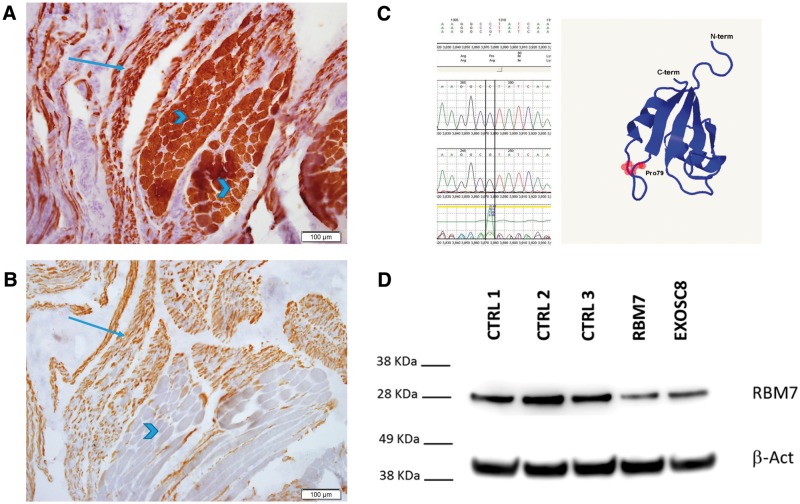
Frozen sections stained with immunohistochemical stains for slow- (A) and fast-myosin (B) display striated muscle tissue with large group atrophy, including atrophic myofibers of both types, alongside groups of hypertrophic myofibers, most of them type 1. The c.236C > G; p.Pro79Arg mutation identified by Sanger sequencing is predicted to be pathogenic by Mutation Taster (58); (C). The mutated amino acid is located in the RRM domain just before the last β strand forming a four stranded Antiparallel β-sheet. The 3D model was built using Phyre2 according to the structure presented by Hrossova et al., 2015. Immunoblotting of fibroblasts of the patient with RBM7 mutation and EXOSC8 mutant fibroblasts showed reduced RBM7 protein levels in both patients compared with three control fibroblast lines (D).